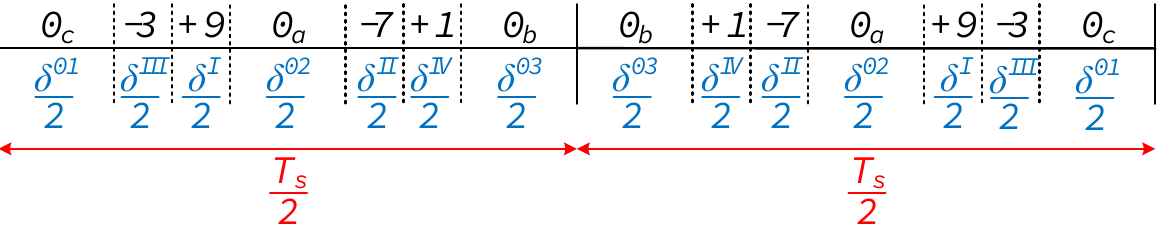
Figure 9. General double-sided switching pattern in a switching period T s with K V = K I =